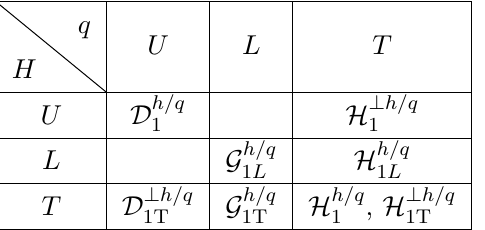
Table 3 . Interpretation of TMDJFFs for quarks. The rows indicate the hadron polarization — unpolarized (U), longitudinally polarized (L), transversely polarized (T). And the columns indicate the quark polarization